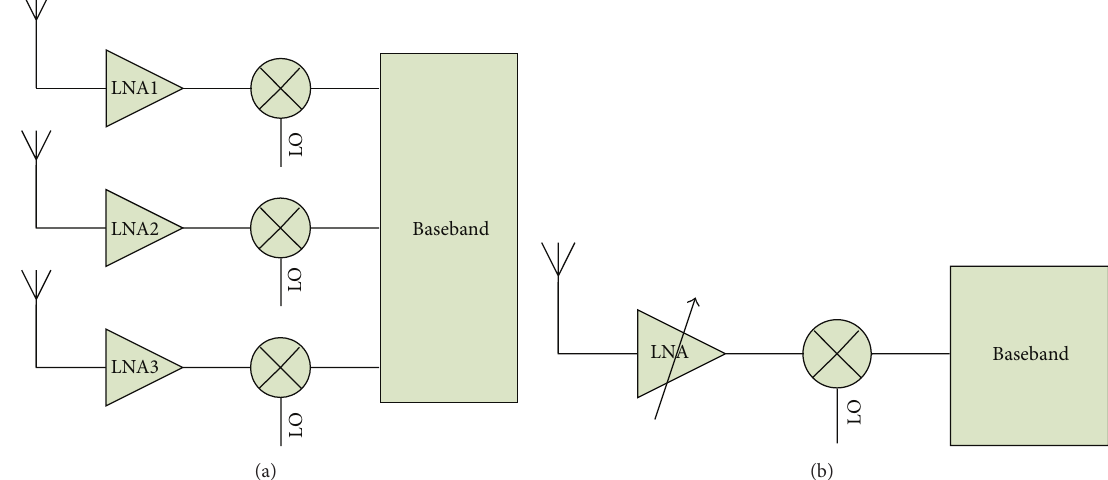
Figure 1: (a) Multiband receiver architecture. (b) Wideband or tunable-band receiver architecture.